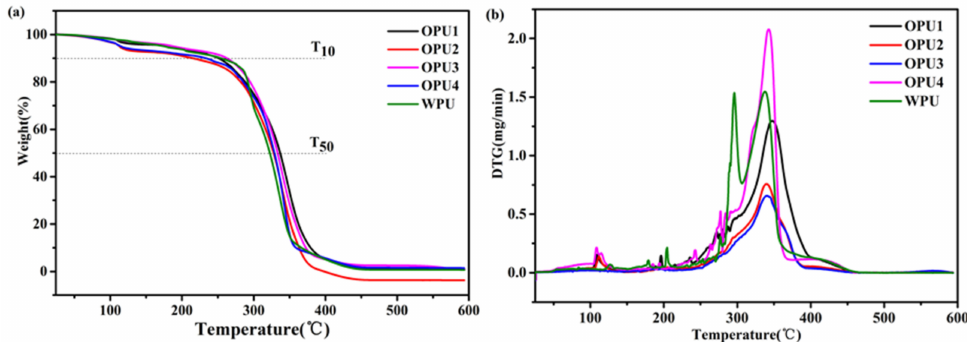
Figure 3. Thermal stability of WPU and OPUs: ( a ) TGA curves and ( b ) DTG curves.